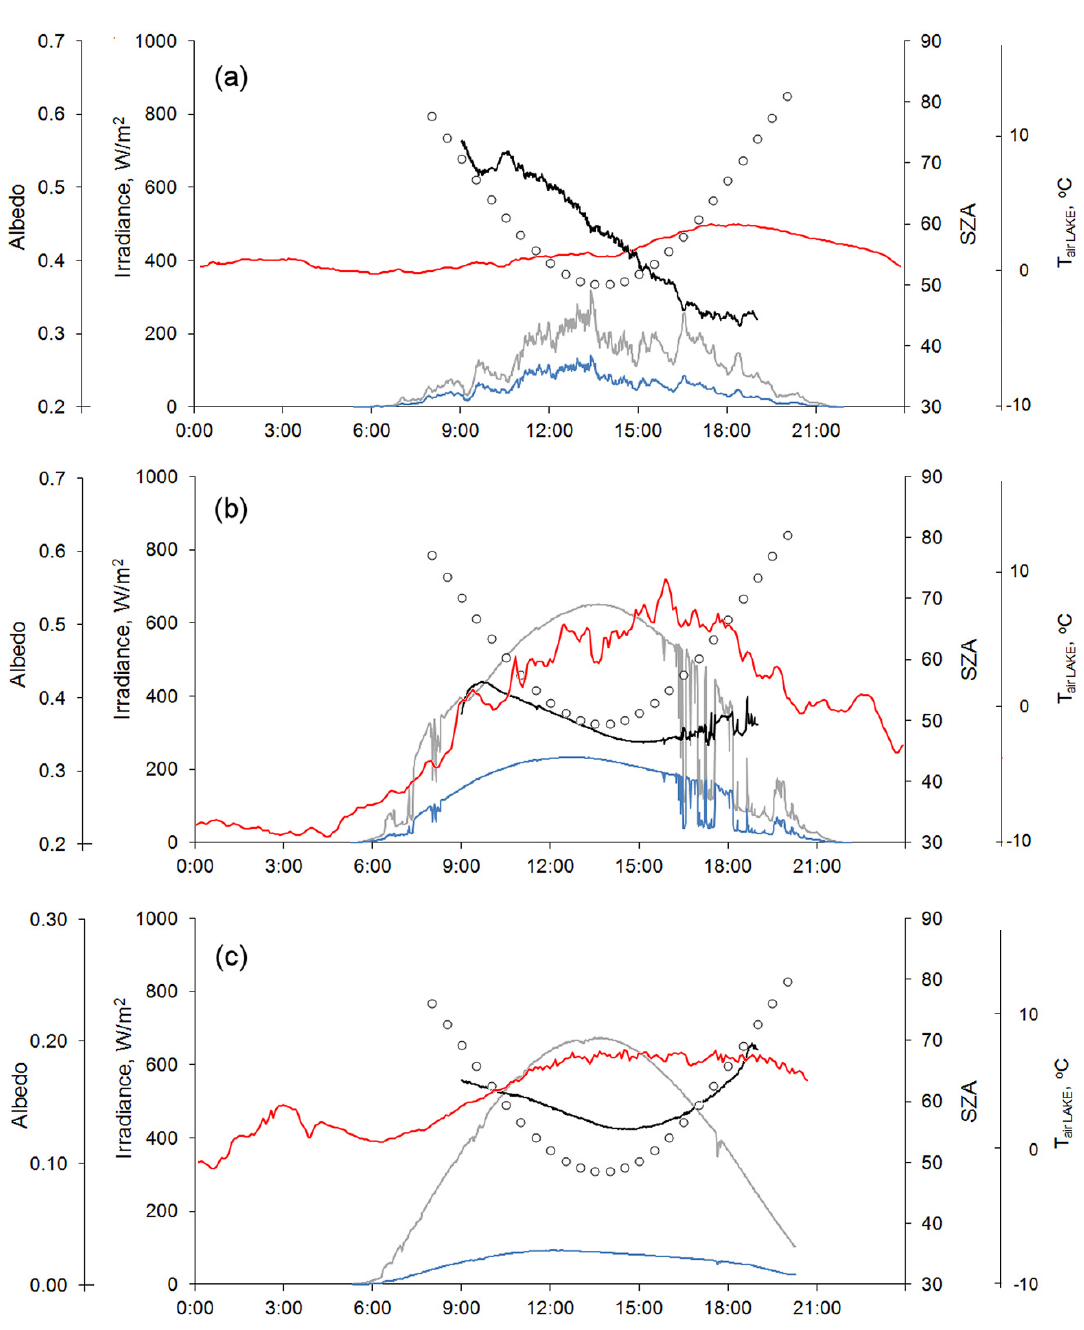
Figure 5. Temporal variability of downwelling (grey lines) and upwelling (blue lines) irradiance, albedo (black bold lines), solar zenith angle (circles) and air temperature near Lake Vendyurskoe (red lines) during April 22, 2006 ( a ), April 24, 2006 ( b ), and April 27, 2006 ( c ).